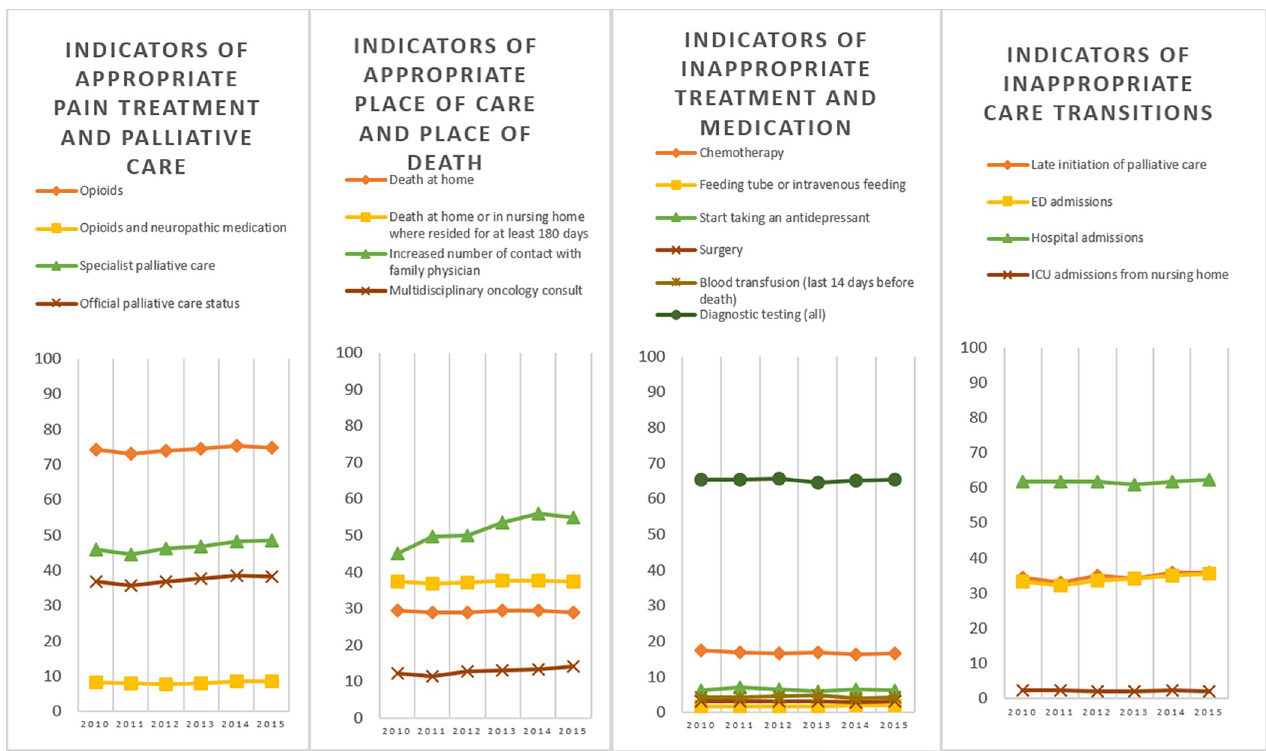
Fig 1. Trends in indicators of appropriate or inappropriate care in the last 30 days of life for people dying from cancer, thematically grouped. The Y-axis represents the risk adjusted percentage of the population that received the treatment or care specified for this quality indicator.